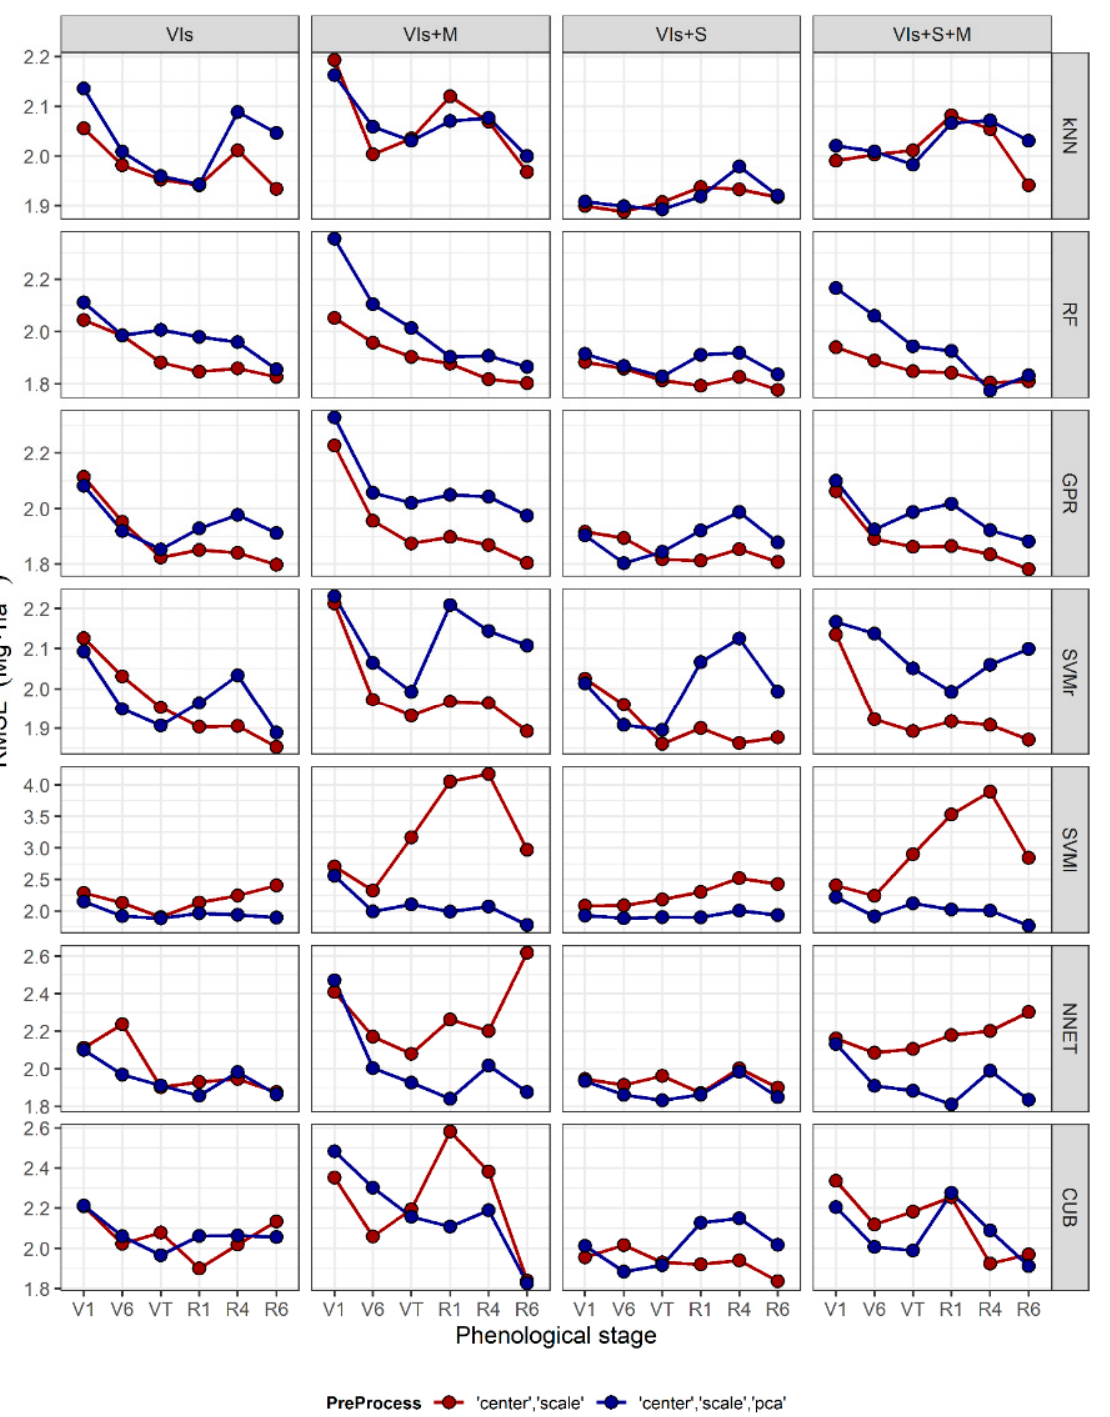
Figure 5. Impact of feature sets and data reduction on yield prediction performance (RMSE) at six phenological stages for four feature sets (VIs, VIs + M, VIs + S, VIs + S + M) and data reduction PCA) using the seven ML algorithms (kNN, SVMr, RF, CUB, GPR, SVMl, and